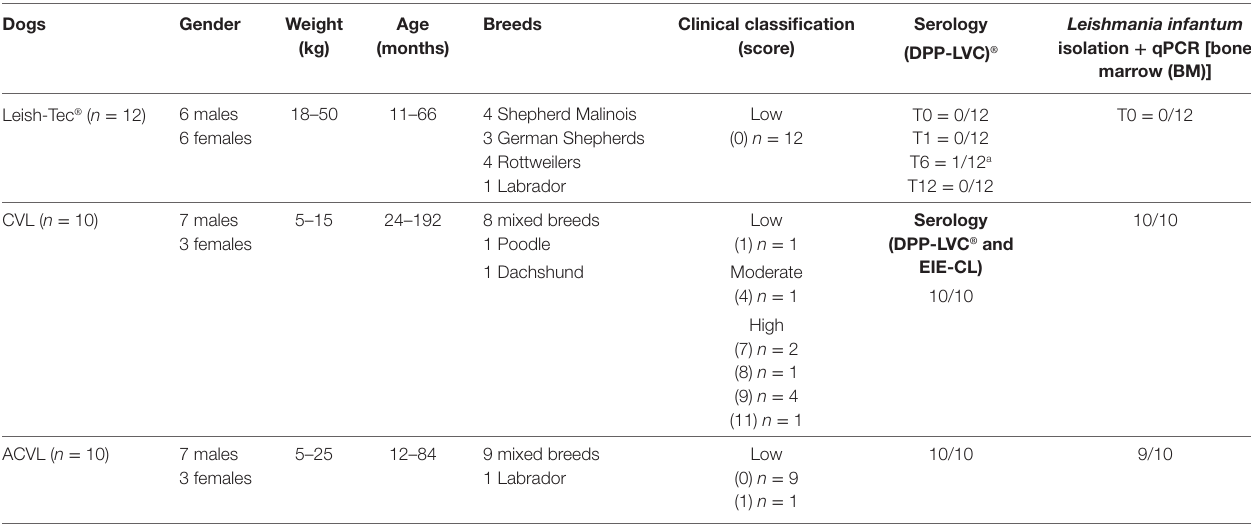
TaBle 1 | Dog characterization accordingly to gender, weight, age, breed, clinical classification, serological response to Leishmania , parasite isolation, and detection by quantitative polymerase chain reaction (qPCR). Dogs gender Weight age Breeds clinical classification (kg) (months)